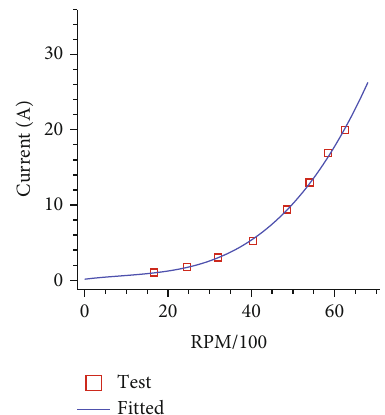
Figure 12: Test system and data fl ow.